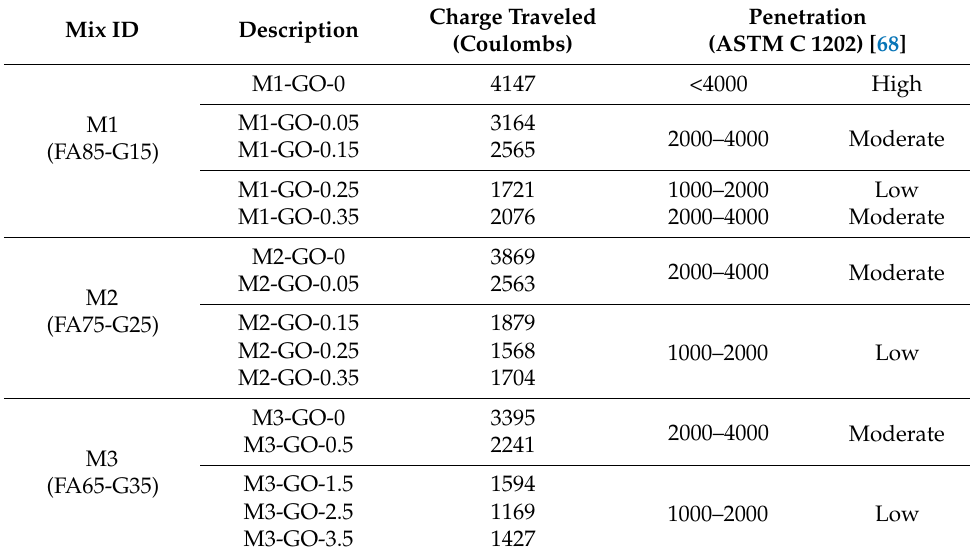
Table 5. Lab outcomes of a rapid chloride penetration